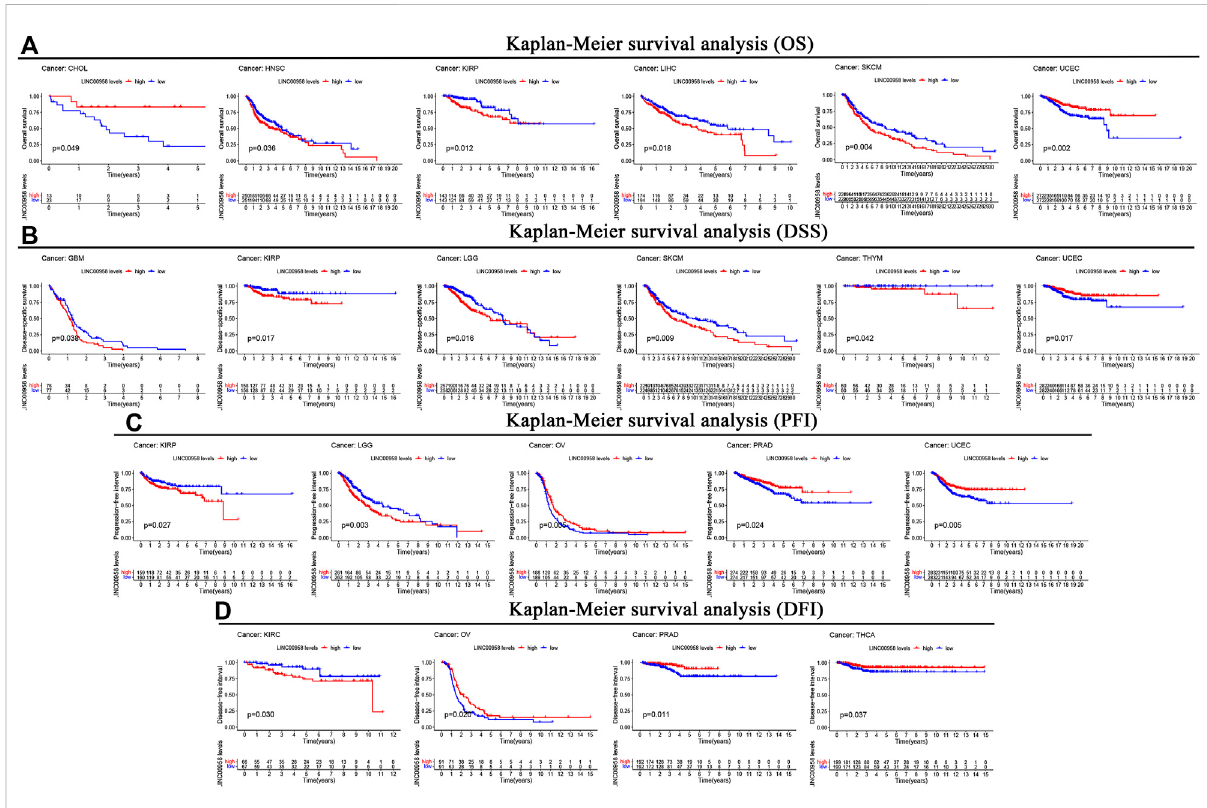
FIGURE 6 Kaplan-Meier survival curves comparison of high and low expression of LINC00958 for different cancer types. (A) OS. (B) DSS. (C) PFI. (D)